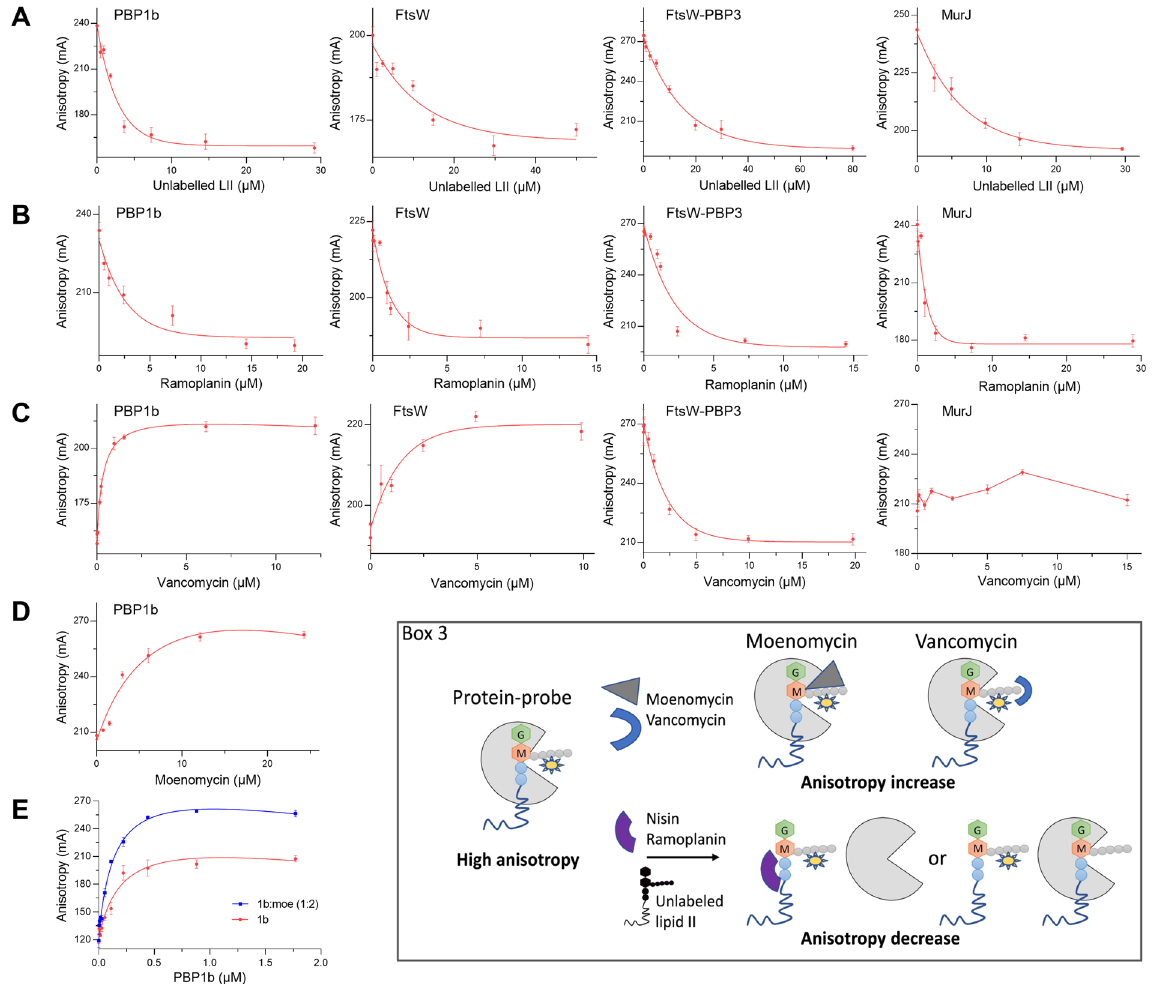
Figure 3. Competition assays of unlabelled lipid II and antibiotics for the proteins (PBP1b, FtsW, FtsW-PBP3 and MurJ)/NBD-lipid II binding show FA modifications (increase or decrease) of the probe. FA (in mA units) is plotted as a function of compound concentrations. The error bars represent the FA values as mean ± s.d. of triplicate experiments using the same buffer and protein conditions. ( A,B ) Competitive displacement of the NBD-lipid II probe from binding proteins by unlabelled lipid II and ramoplanin. ( C ) The increase of FA with vancomycin indicates the formation of a ternary complex with PBP1b:probe and FtsW:probe; the decrease of FA in the presence of vancomycin indicate competitive displacement of the probe from FtsW-PBP3; the addition of vancomycin to MurJ:probe does not induce significant modification of the FA. ( D ) Binding of the probe to PBP1b in the presence of increasing moenomycin concentrations, moenomycin induces an increase of FA indicating the formation of a ternary complex with PBP1b:probe. ( E ) Moenomycin binding to PBP1b (PBP1b:moenomycin,1:2 molar ratio) induces and increase the FA compared to PBP1b alone. Box 3 schematically illustrates the corresponding FA assays and the observed FA